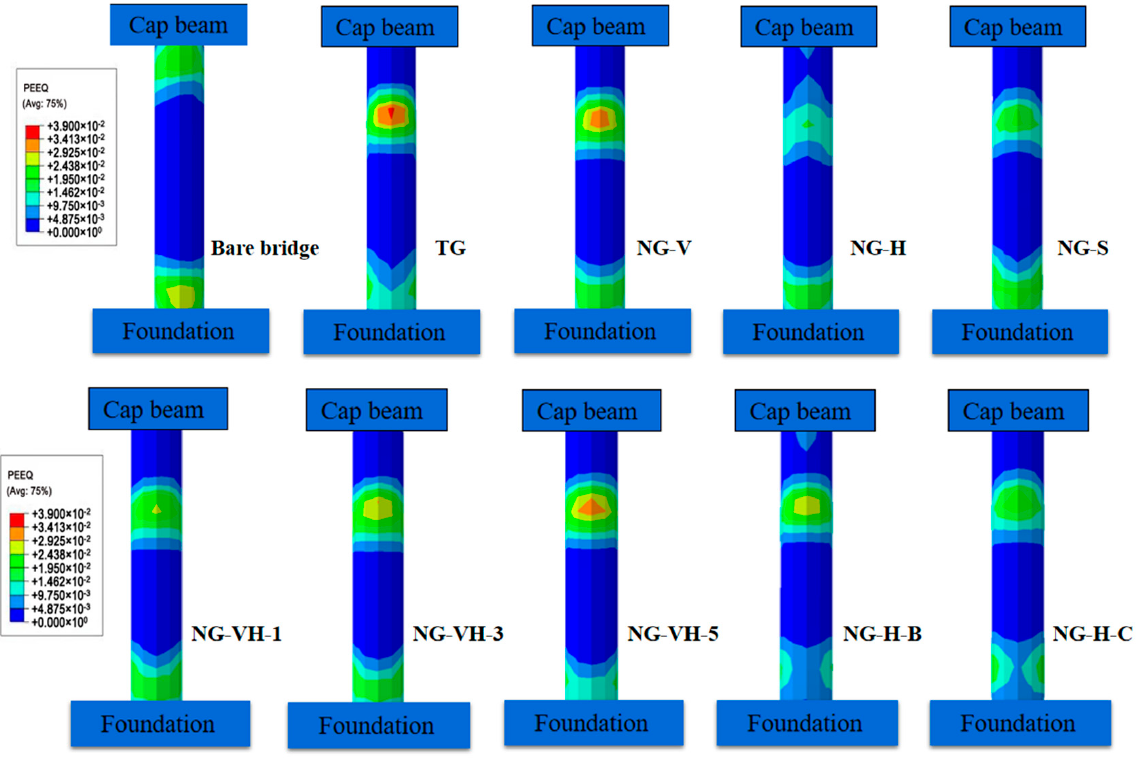
Figure 20. PEEQ on right pier columns at 2% drift.